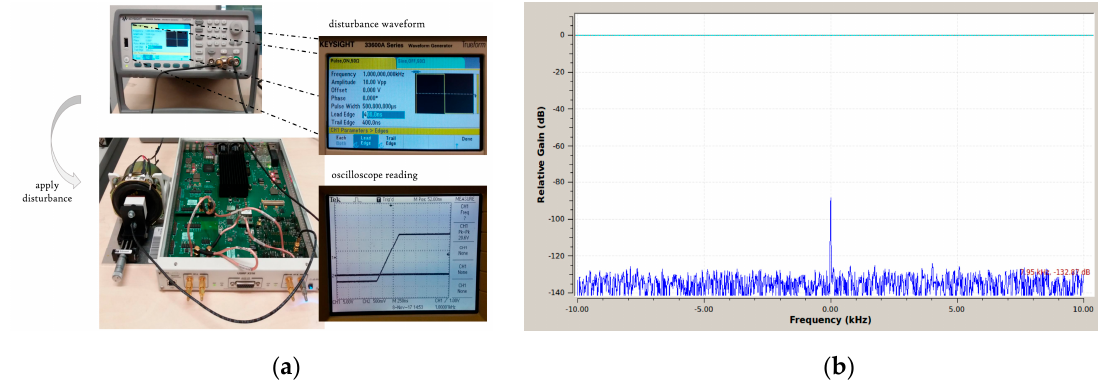
Figure 3. Illustration of the robustness analysis setup and results. ( a ) Demonstrator-setup to evaluate the robustness against disturbers. ( b ) Measurement results with a disturbance signal applied to the counter electrode of the mirror position